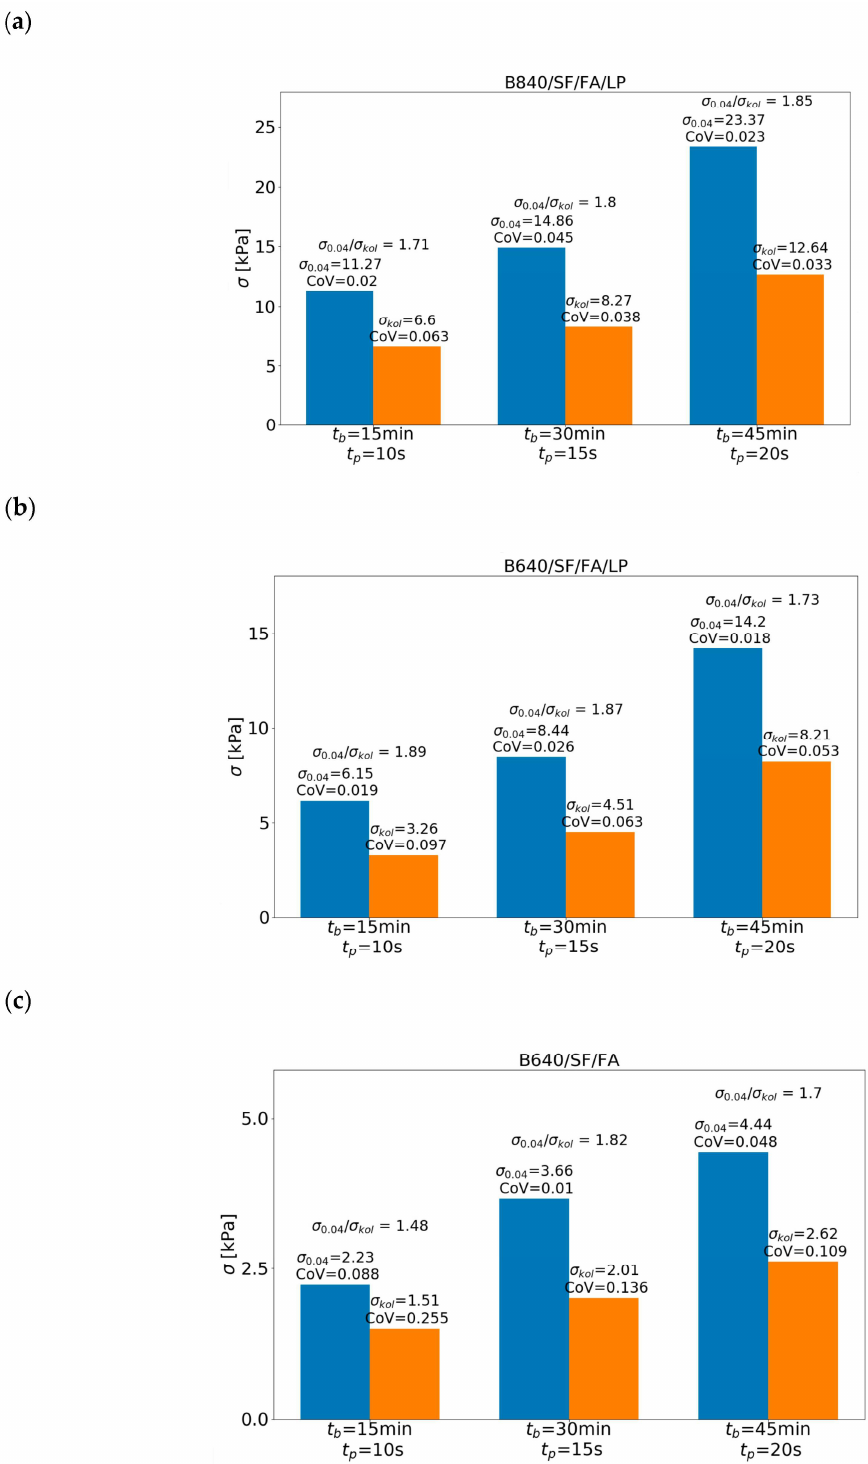
Figure 17. The comparison of load-bearing capacity calculated based on the time of collapse of the columns and obtained in the printing simulation test. ( a ) B840 / SF / FA / LP; ( b ) B840 / SF / FA / LP; ( c ) B640 / SF /